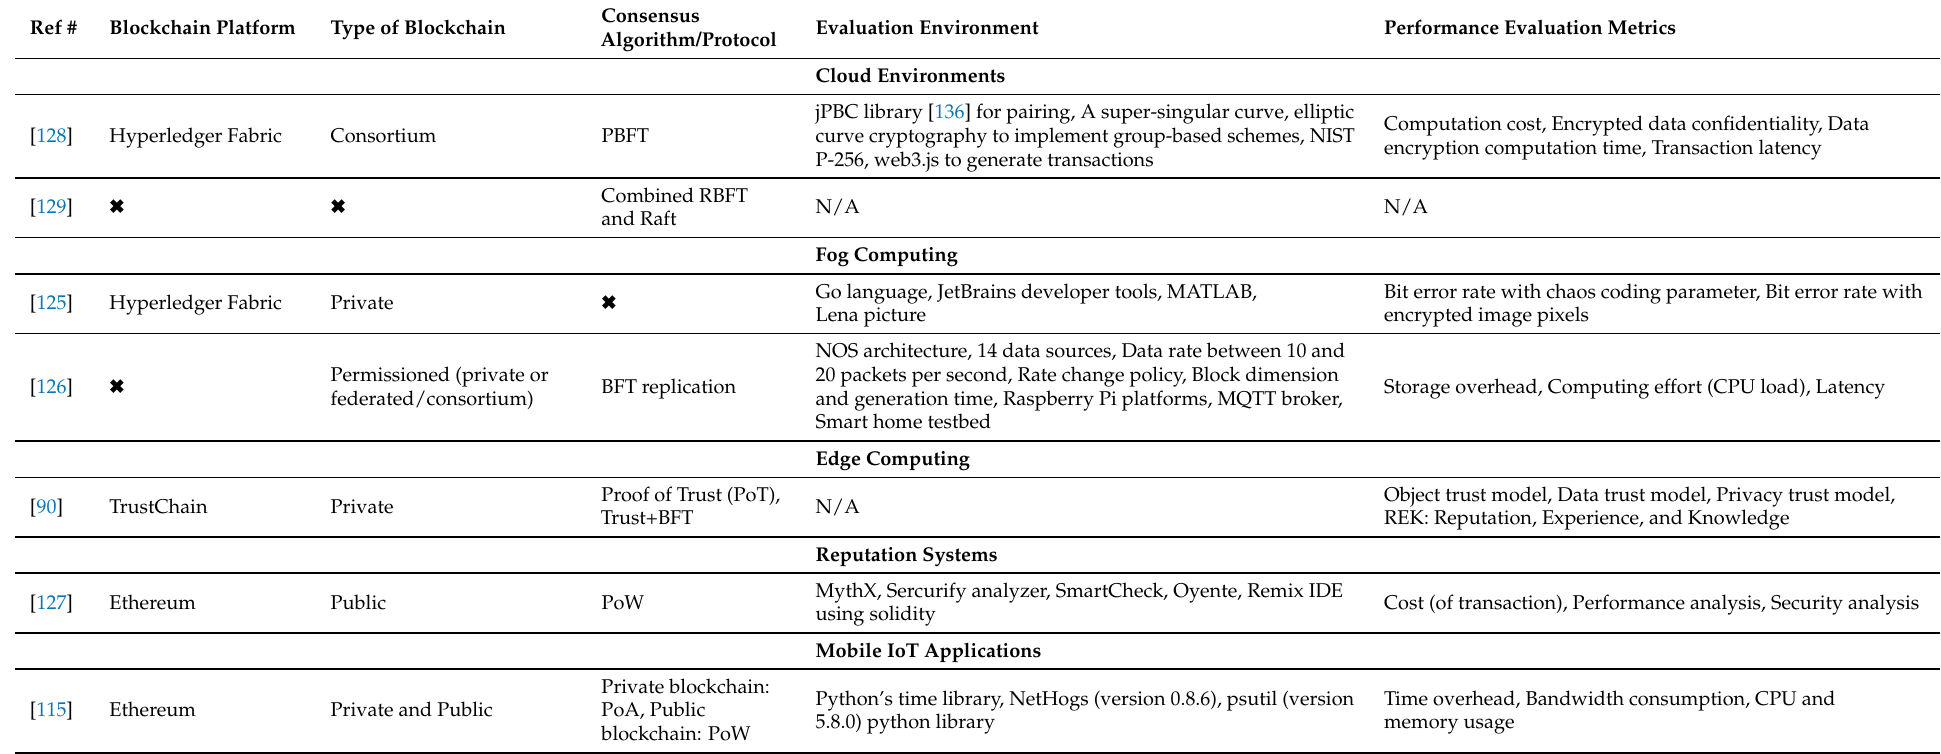
Table 7. Other Articles: Blockchain Characteristics, Evaluation Environment, and